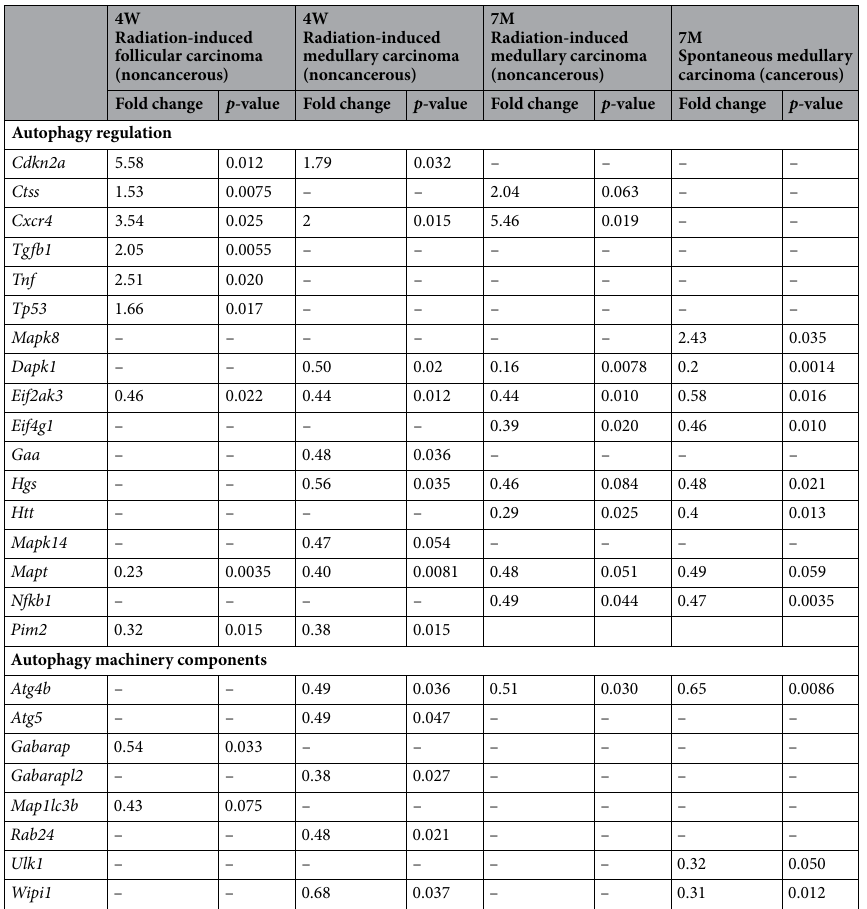
Table 3. Expression of autophagy-related genes in radiation-induced and spontaneous thyroid carcinoma cases in 4W and 7M rats. Fold change represents the average of triplicate experiments from single rats. Results are expressed relative to nonirradiated normal thyroids in 4W or 7M